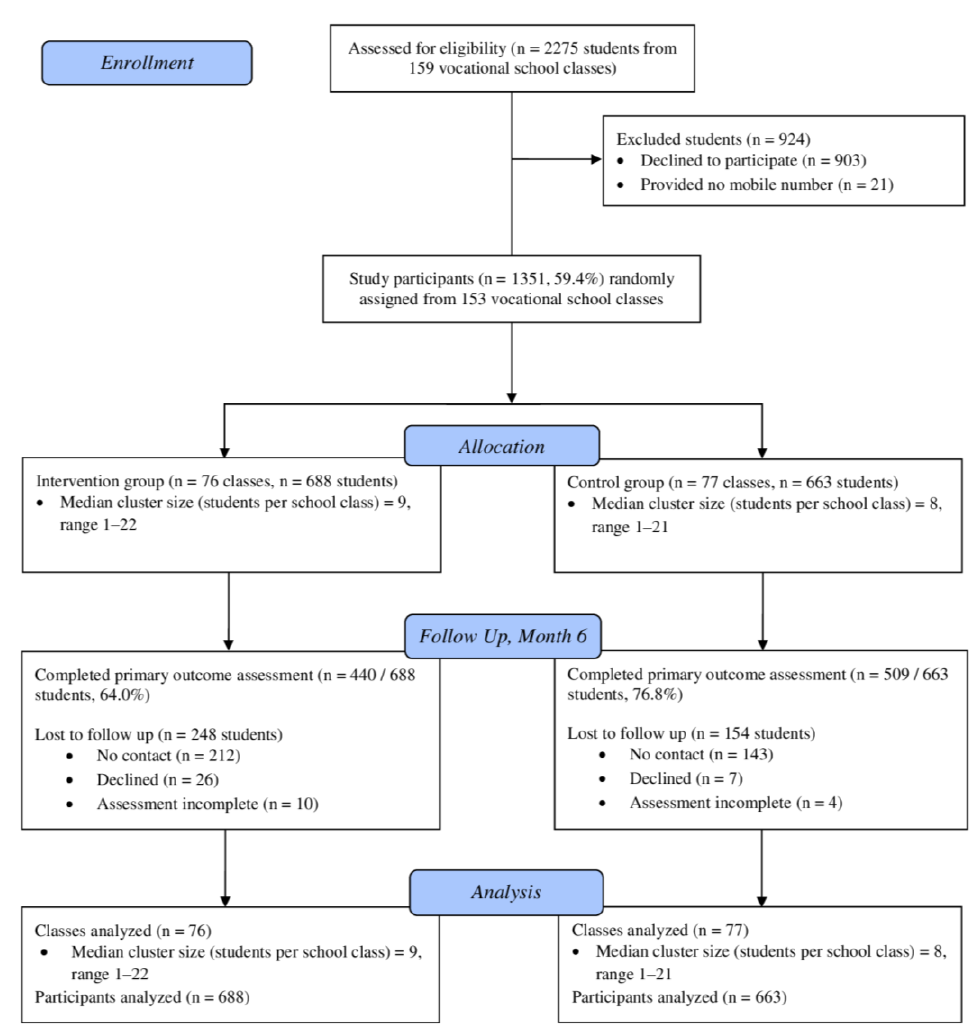
Figure 1. Flow of study participants.